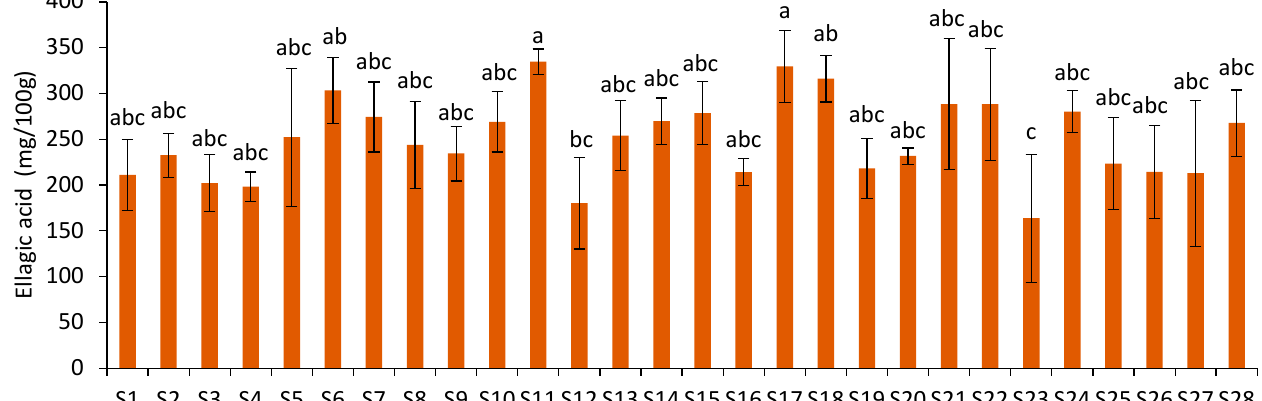
Figure 5. Ellagic acid content of JPF samples. Different letters in different samples indicate that values are significantly different ( p < 0.05).